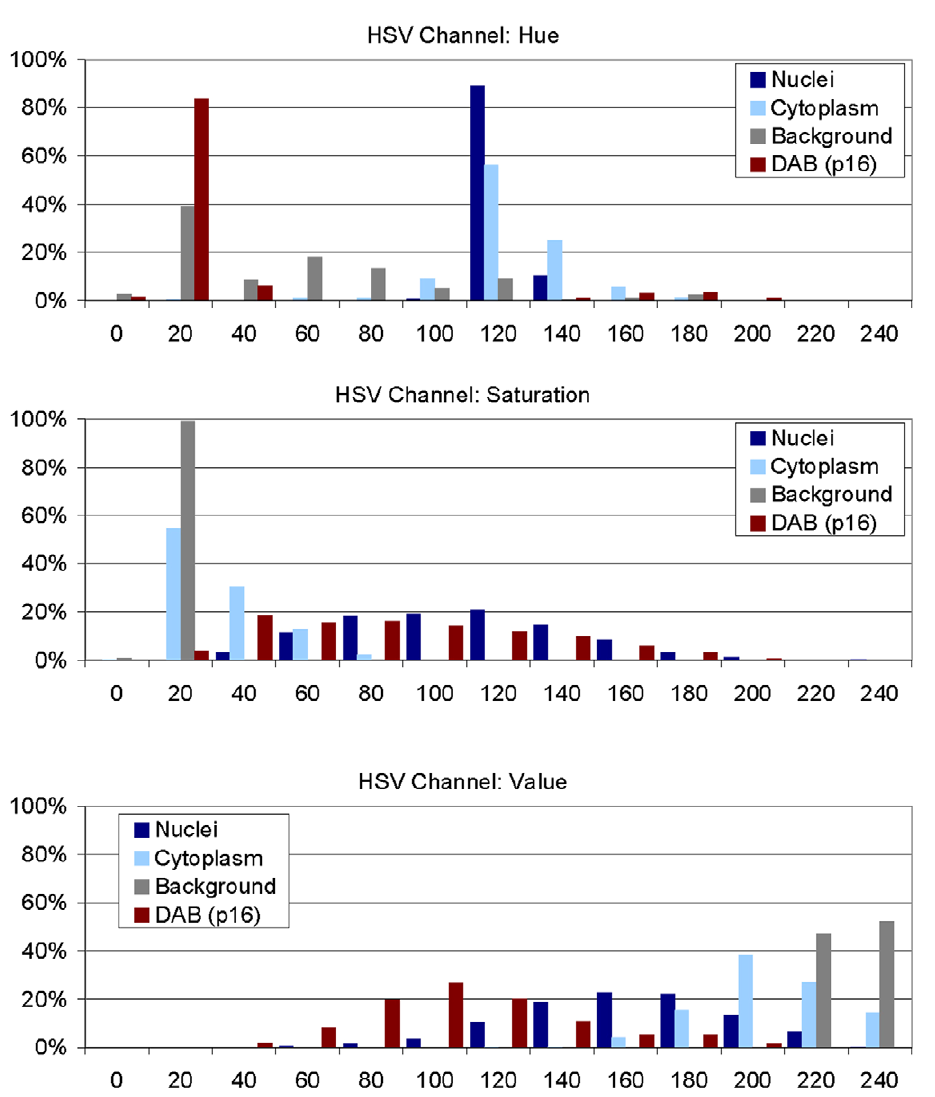
Fig. 3. Analysis of objects in HSV color space. 340 images of nuclei, cytoplasm, background, and p16-stained cells (85 images each) have been analyzed for their composition in the HSV color model after conversion from the original Red–Green–Blue (RGB) images. From each image 10 pixel have been collected, yielding a training data set of 3400 pixels from which the classifiers for nuclei, cytoplasm and p16 stain were developed. In each channel (Hue, Saturation, Value) distinct distributions can be identified allowing discriminating of the image sets. 52 different slides from five different staining